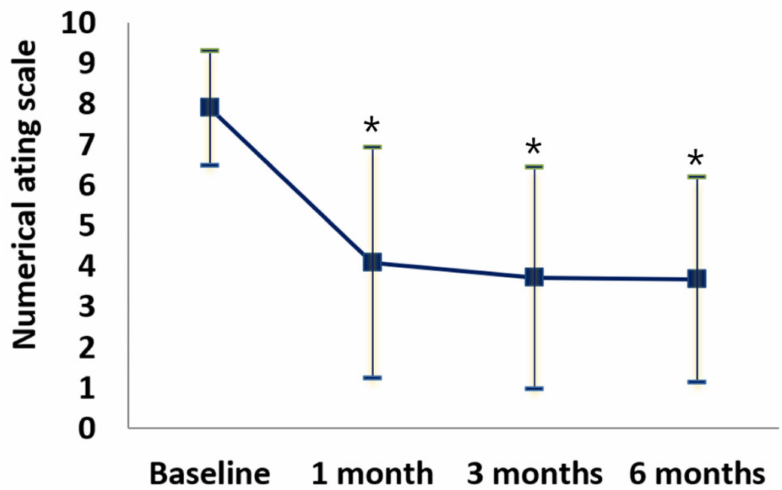
Figure 4. Numerical rating scale of lumbar radicular pain with or without lower back pain at baseline, 1, 3, and 6 months after combined epidural adhesiolysis and balloon decompression. * p < 0.001 versus